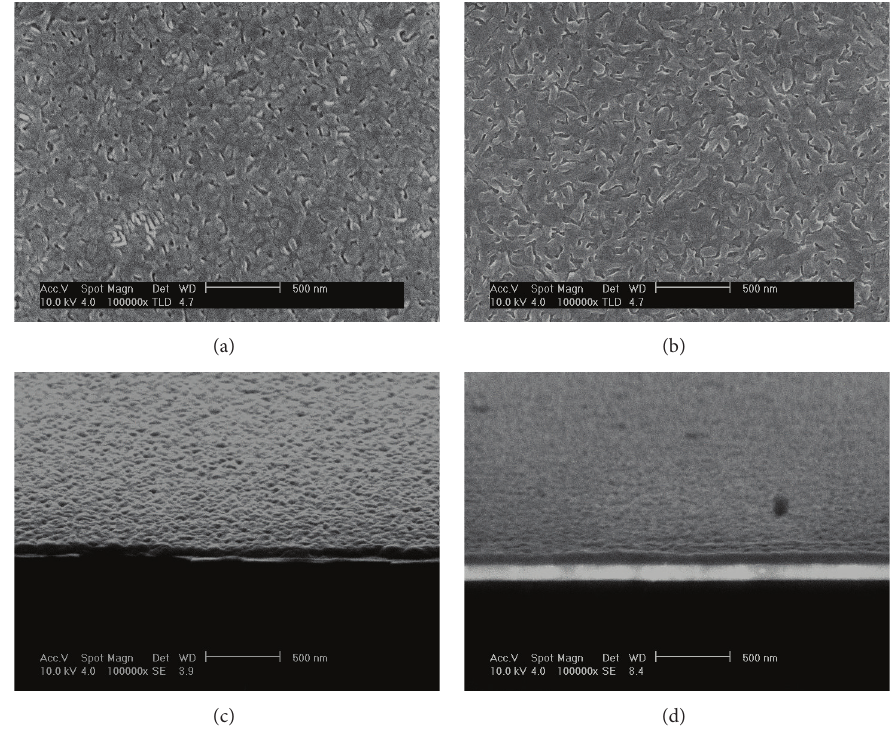
Figure 5: (a) SEM images of PbPc films prepared by GLAD at 𝛼 = 75 ∘ , (b) SEM images of PbPc films prepared under normal conditions, (c) the side views of PbPc films prepared by GLAD at 𝛼 = 75 ∘ , (d) the side views of PbPc films prepared under normal conditions.